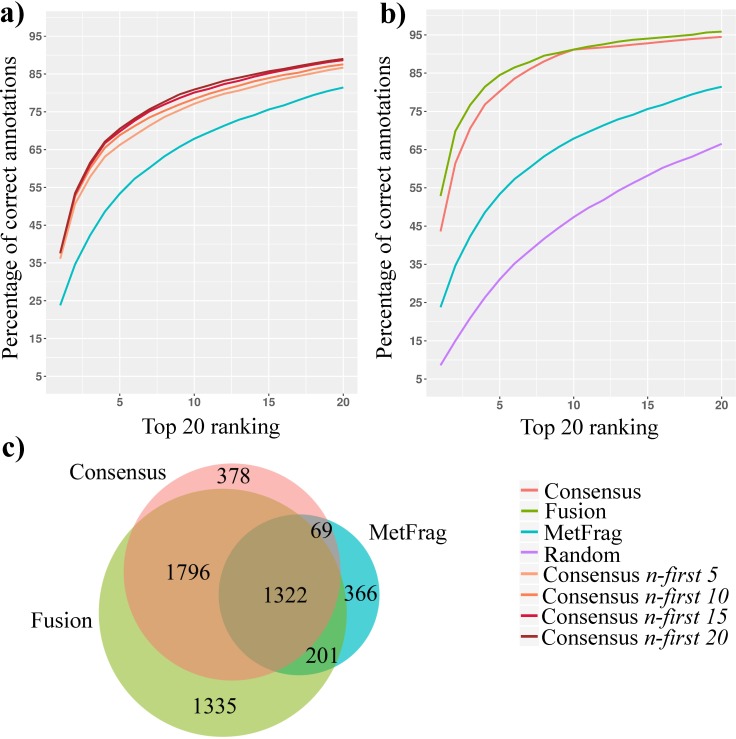
NAP re-ranking assessment using the 5,467 NIST17 [M+H]+ benchmark data set that have known nearest neighbors in the molecular network.a) The impact of setting the n-first parameter on percentage of correct annotations for network Consensus scoring. Where n-first indicates the n number of top ranked candidate structures (from 5 to 20) considered from the neighbor nodes during the Consensus scoring. b) Percentage of correct annotations ranking for each method. c) Number of spectra with improved ranking of correct annotations, that is, for which Fusion or Consensus scoring ranked the correct structure better than MetFrag.